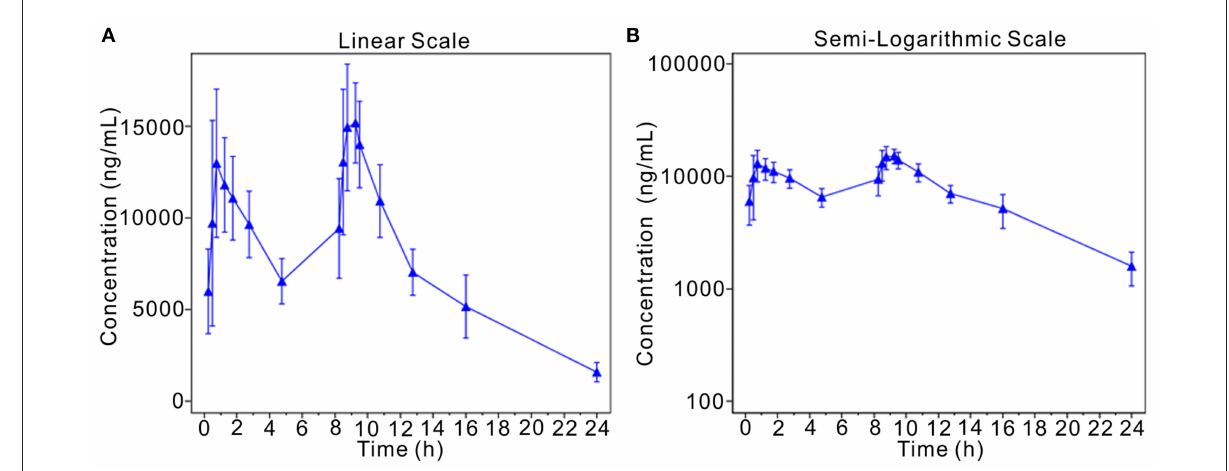
FIGURE2 Mean plasma concentration-time curve (linear and semilogarithmic). The average drug concentration-time curves ( A , linear; B , semilogarithmic).